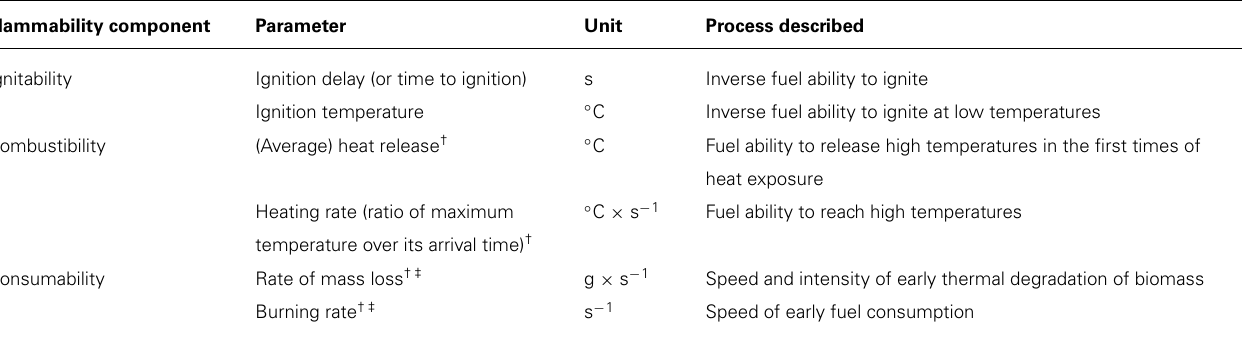
Parameters are associated with the different flammability components sensu Anderson (1970) and Martin etal. (1994) as described byWhite and Zipperer (2010). † Variables computed on time period encompassing bark flameless pyrolysis and bark flaming combustion stages, i.e., the ignition ability (180 s from heat exposure). ‡ Variables computed also on time period of bark flaming combustion only (90 s from